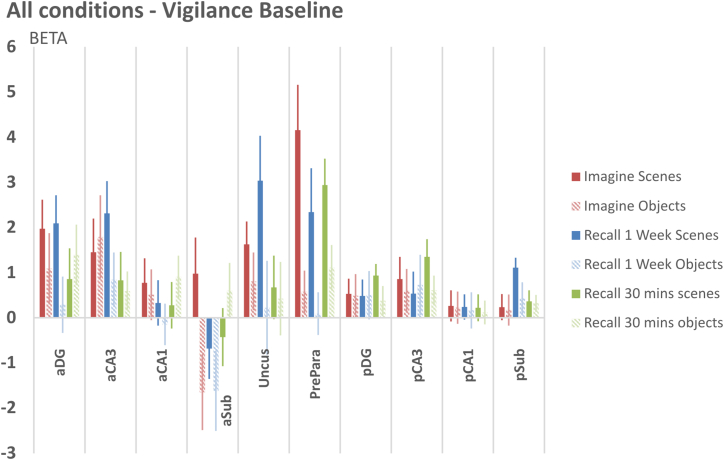
All responses versus the fixation baseline task. The plot shows parameter estimates for all experimental conditions (scenes and objects) versus the fixation baseline task in each region of interest. aDG = anterior dentate gyrus, aCA3 = anterior CA3, aCA1 = anterior CA1, aSub = anterior subiculum, PrS/PaS = presubiculum/parasubiculum, pDG = posterior dentate gyrus, pCA3 = posterior CA3, pCA1 = posterior CA1, pSub = posterior subiculum. ±1 SEM.